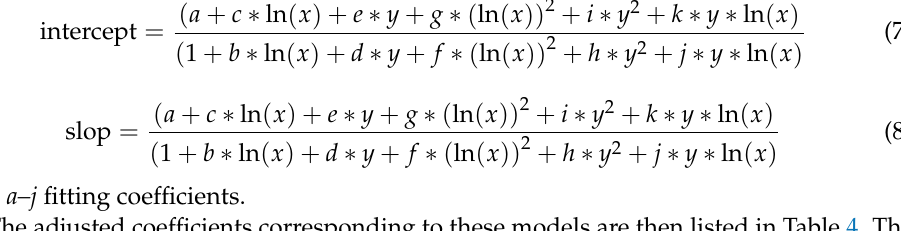
Table 4. Fitted coefficients and their standard errors (in parentheses) of the mathematical models, as shown in Equations (7)-(8).